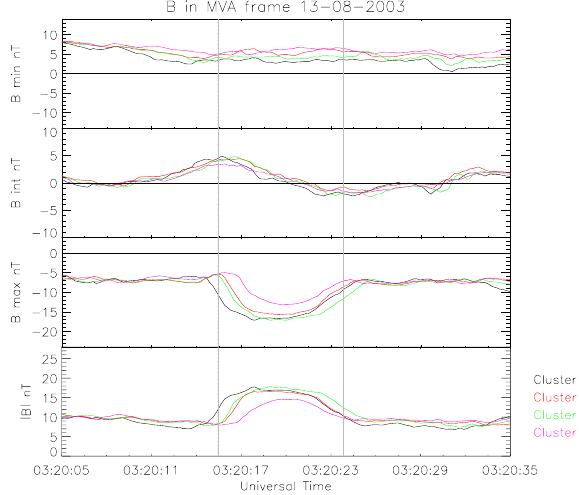
Fig. 12. Magnetic field observations from 13 August event trans- formed into the variance frame of Cluster 1 in the same format as Fig. 5.